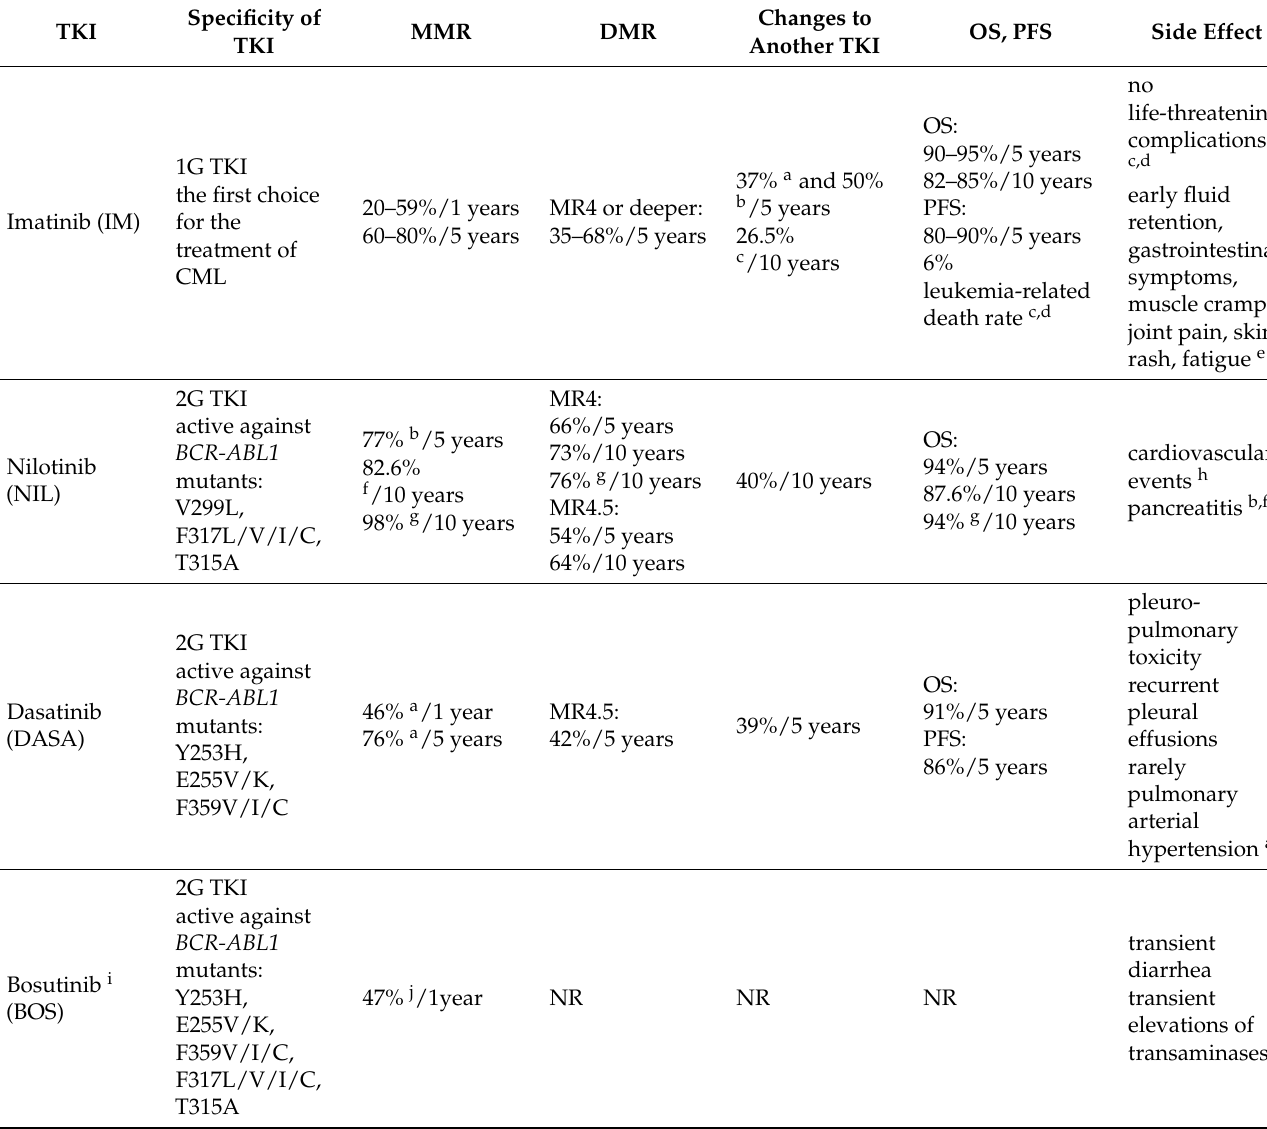
Table 1. First- and second-line-generation